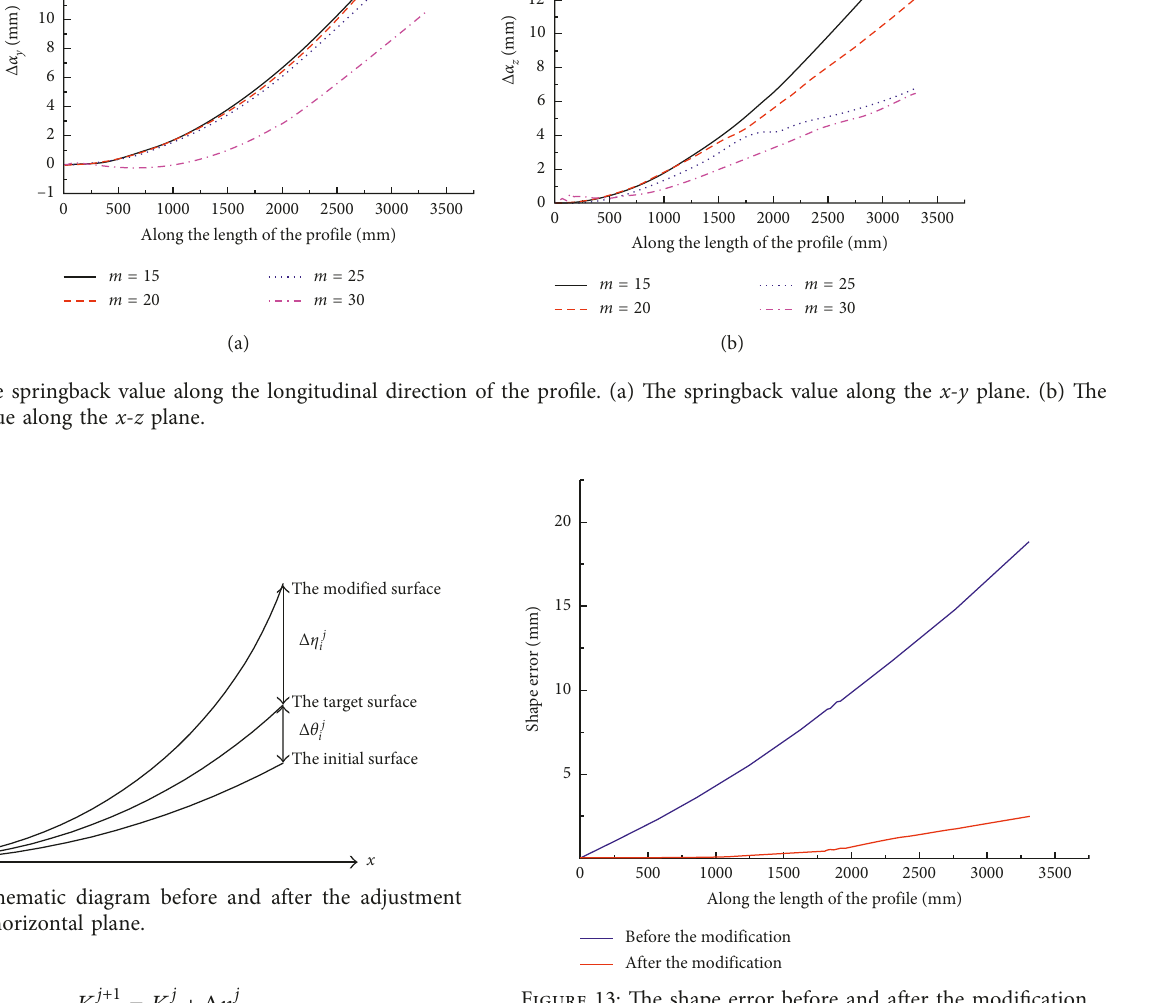
Figure 13: The shape error before and after the